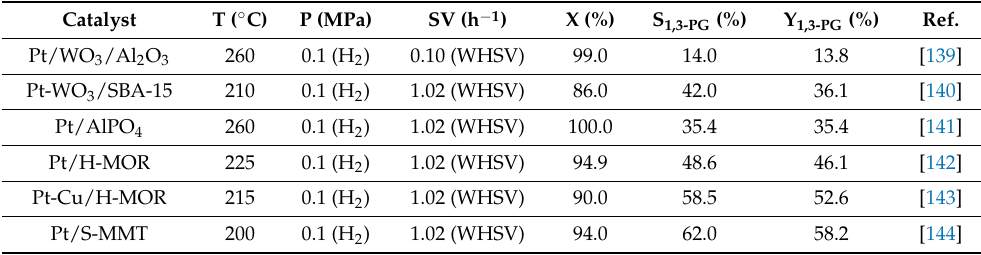
Table 6. The hydrogenolysis of glycerol to 1,3-PG using Pt catalysts operating in liquid phase continuous flow